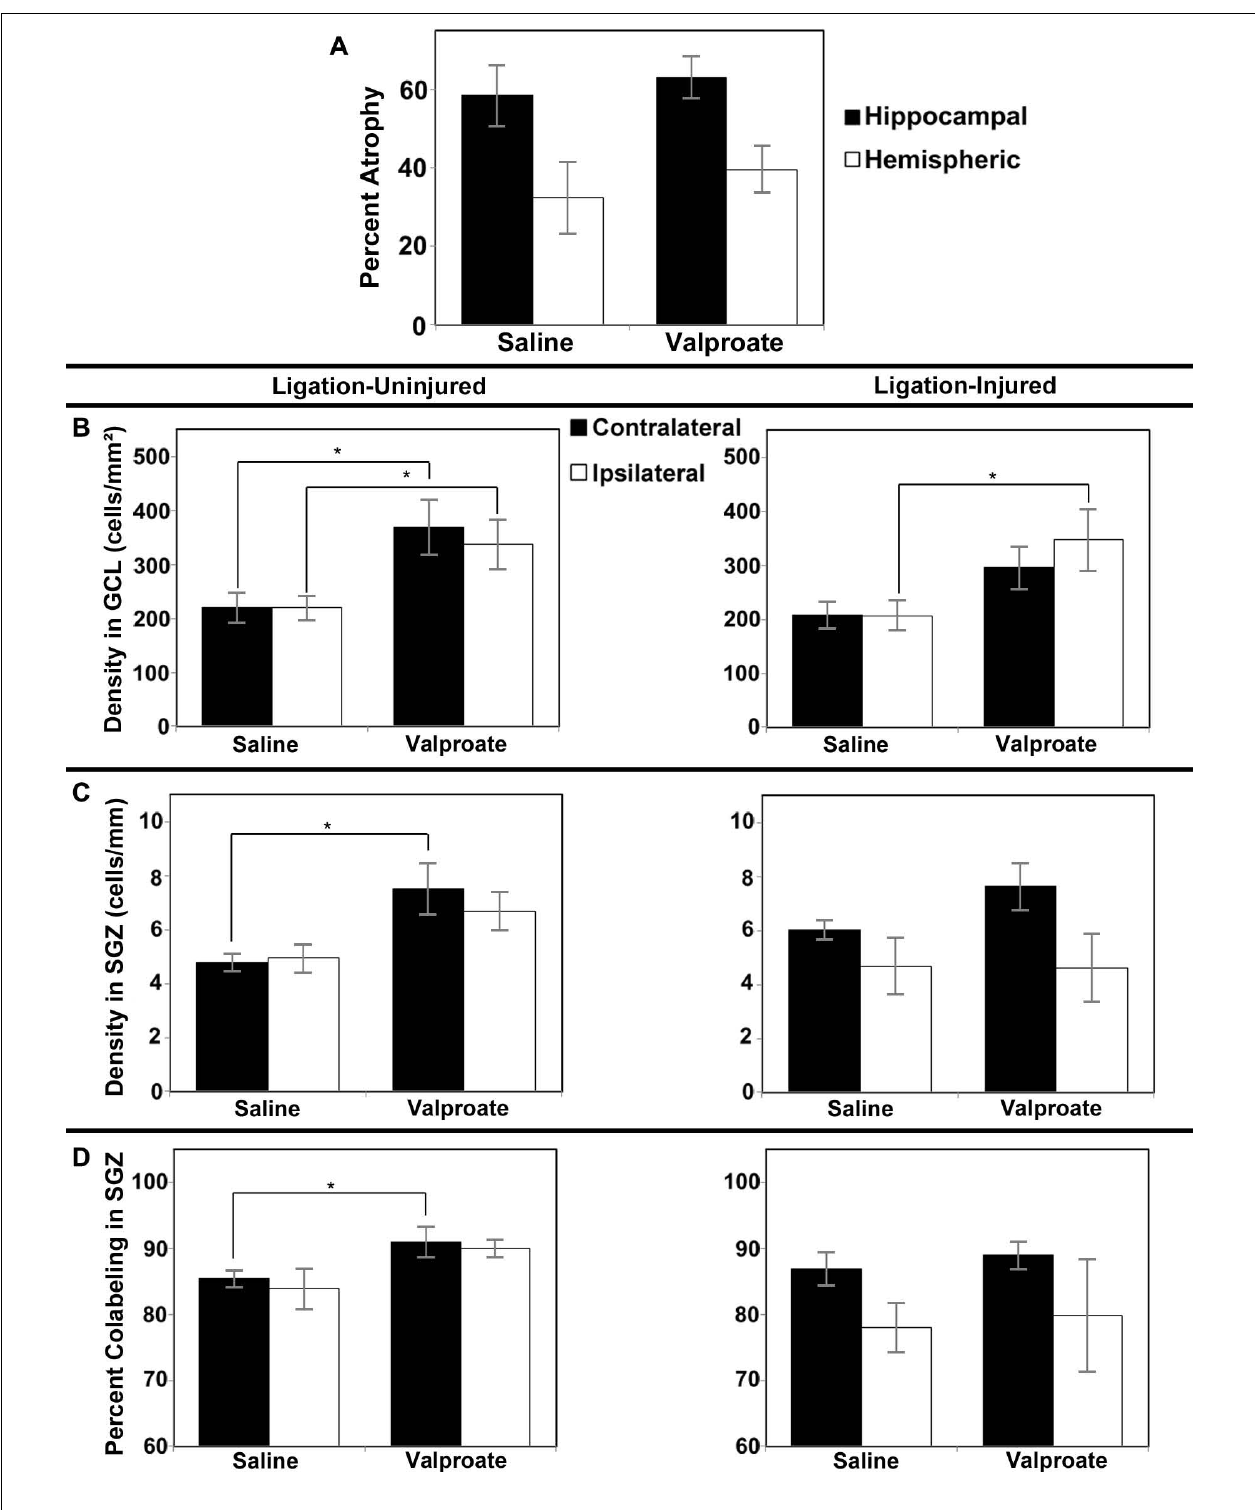
FIGURE 4 | Brain atrophy and dentate gyrus neurogenesis after valproate treatment in Protocol 2. (A) Severity of hemispheric and hippocampal brain atrophy following P12 ligations quantified at P42 in ligation-injured mice. (B) Average densities of BrdU + /NeuN + within the GCL in both ligation-uninjured (left panel) and ligation-injured (right panel) mice treated